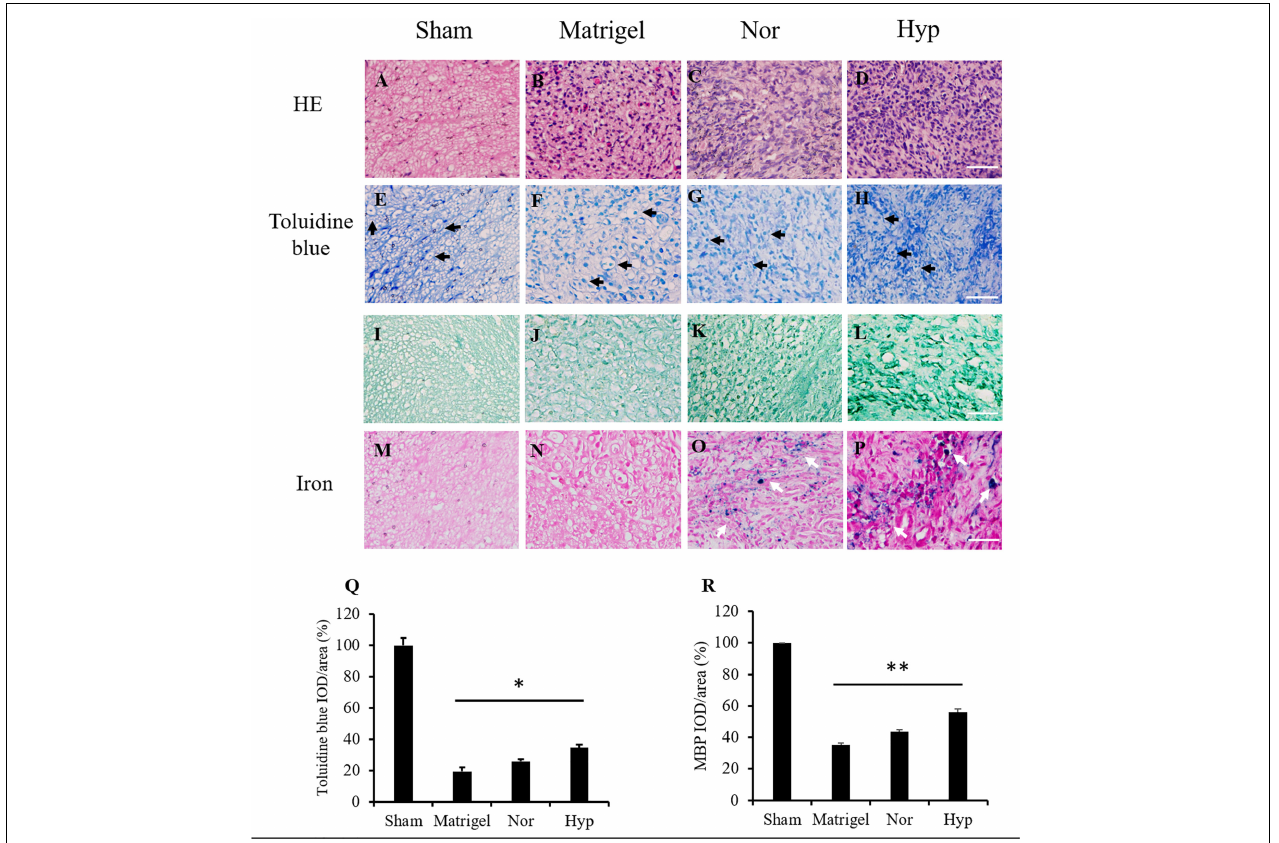
FIGURE 5 | Histologic staining of the nerve sections. The sections in the middle part of the sciatic nerve from the sham group (A) and the regenerated nerve from the Matrigel (B) , normoxic (C) , and hypoxic rat ADSCs (rADSCs) (D) were stained by hematoxylin and eosin (HE) staining. Toluidine blue was applied to detect nerve fibers (black arrows) from the sham (E) , Matrigel (F) , normoxic, (G) and hypoxic rADSCs (H) , the results of which were showed in the second row. Myelin basic protein (MBP) immunostaining was applied to detect myelin in the sham (I) , Matrigel (J) , normoxic (K) , and hypoxic rADSCs (L) , the results of which were showed in the third row. Iron particles (white arrows) in the injected rADSCs were also tracked in the sham (M) , Matrigel (N) , normoxic (O) and hypoxic rADSCs (P) (Magnification × 400; the scale bar = 100 µ m). The nerve fibers from (E–H) and (I–L) were quantified by the Image-Pro Plus (v4.5.0.29, Media Cybernetics), respectively. (Q,R) The coverage percentages of the myelinated nerve fibers from three sections of each group (E–H) or (I–L) were calculated and normalized with those of the sham group. The values were converted to percentages and expressed as mean ± SD with three experimental replicates. Statistical significance between the multiple groups was analyzed using the one-way analysis of variance (ANOVA) analysis. “*” represented P < 0.05, “**” represented P <